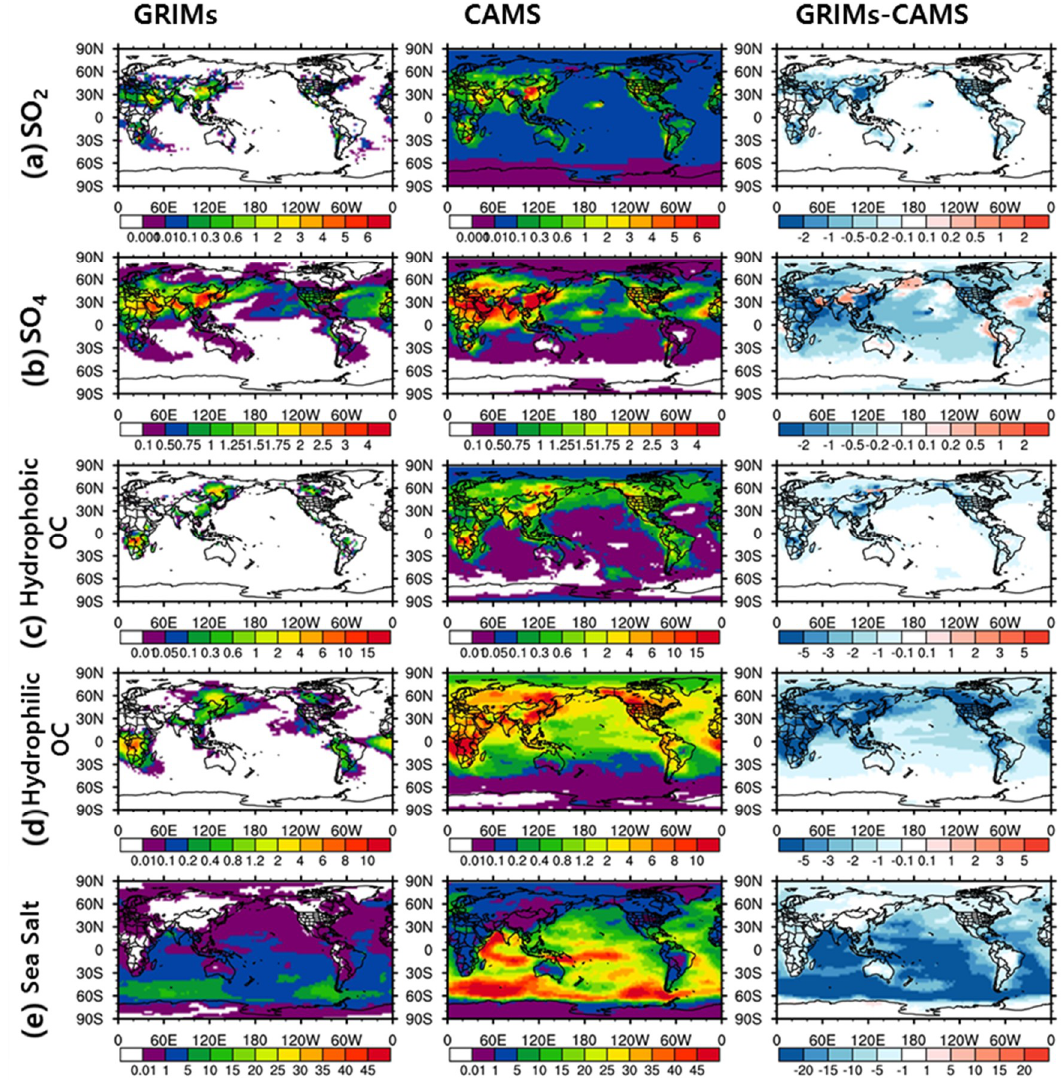
Figure 2. Horizontal distributions of ( a ) SO 2 , ( b ) SO 4 , ( c ) hydrophobic organic carbon (OC), ( d ) hydrophilic OC, and ( e ) sea salt averaged from 700 to 950 hPa which are drawn from the ( first panel ) GRIMs-simulated results, ( second panel ) CMAS reanalysis, and ( third panel ) their differences (GRIMs-CMAS). The values are in g kg -1 and scaled by 1e -6 .